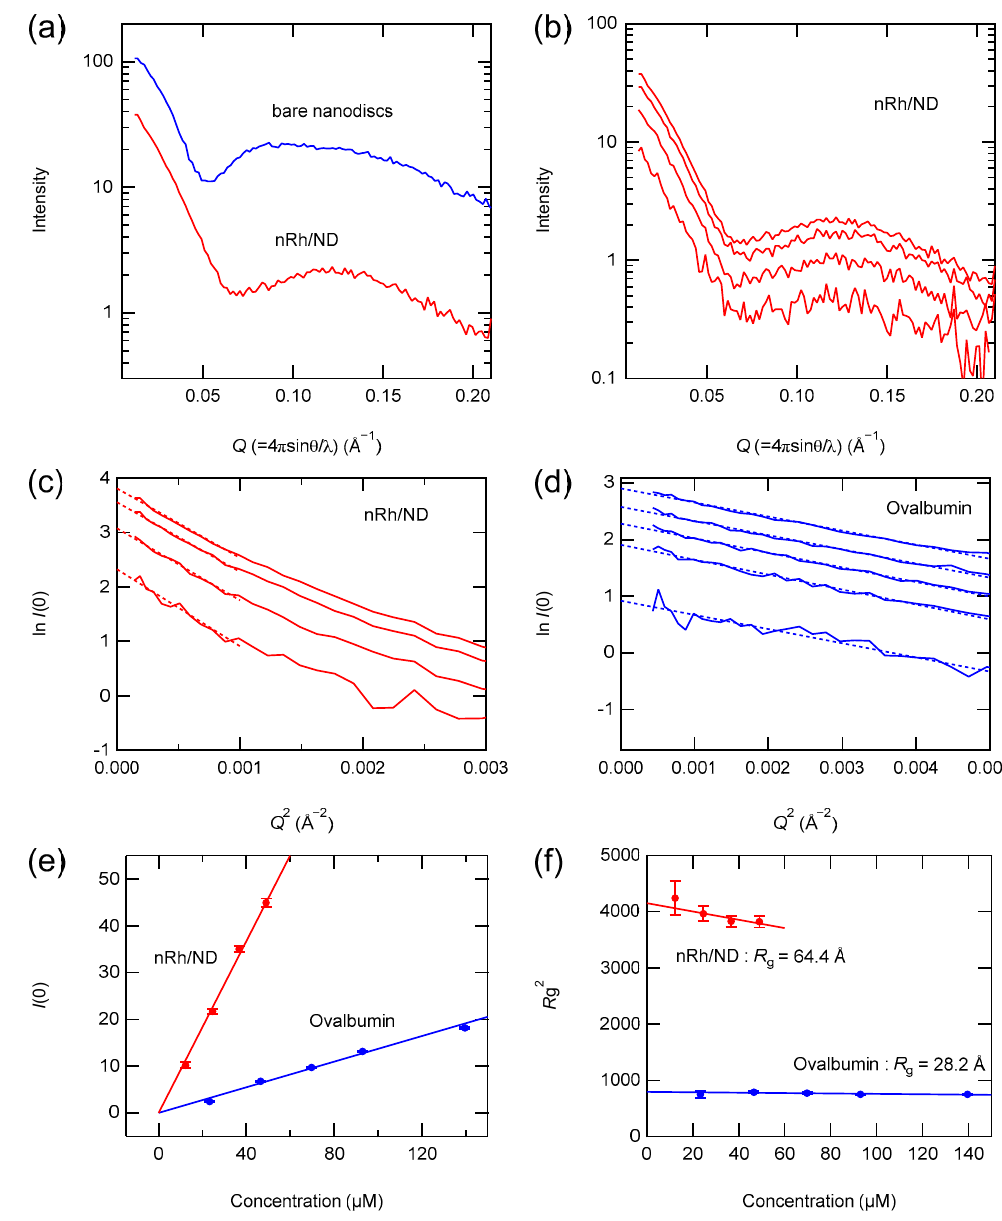
Figure 2. SAXS of nanodiscs containing nRh. (a) SAXS profiles of nRh/ND (red) and bare nanodiscs (blue). (b) SAXS profile of nRh/ND at 12, 25, 37, and 49 µM (from bottom to top, respectively). Guinier plot of (c) nRh/ND and (d) ovalbumin at 23, 47, 70, 93, and 140 µM (from bottom to top, respectively). The scattering curves in the small-angle region were linearly extrapolated to Q 2 = 0, and I (0) and R g2 were estimated by the Y-intersections and slopes of regression lines, respectively (Equation (16)). (e) I (0) of nRh/ND and ovalbumin were plotted against the molar concentration (red and blue, respectively). The apparent molecular weight of nRh/ND was estimated to be 111 K from the slopes of regression lines and the molecular weight of ovalbumin (43 K) (Equation (17)). (f) R g2 of nRh/ND and ovalbumin were plotted against molar concentration (red and blue, respectively). R g was estimated to be 64.4 Å for nRh/ND and 28.2 Å for ovalbumin from the Y-intersection of regression lines. The SAXS profiles were quantitatively analyzed by Guinier analysis, which gives the forward scattering ( I (0)) and the radius of gyration ( R g ) (Equation (16)). The Guinier plot